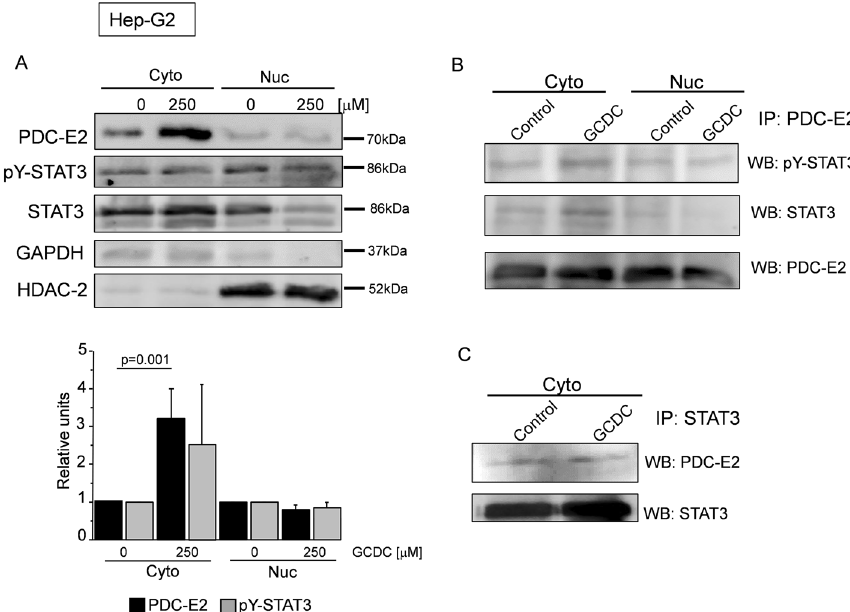
Figure 2. PDC-E2 associates with p-STAT3 and STAT3 in GCDC-stimulated hepatocytes. Hepatocytes (Hep-G2) stimulated with 250 µM of glycochenodeoksycholic acid (GCDC) were collected and subjected to subcellular fractionation in order to obtain cytoplasmic (Cyto) and nuclear (Nuc) fractions. ( A ) PDC-E2, pY-STAT3 and STAT3 were detected by using appropriate antibodies and normalized to GAPDH (cytoplasmic fraction) or HDAC-2 (nuclear fraction). Level of each protein was presented as a mean ± SEM. ( B and C ) Immunoprecipitation reaction (IP) utilized anti-PDC-E2 or anti-STAT3 antibody and contained 500 µg proteins per reaction. PDC-E2 (70 kDa) and pY-STAT3 or STAT3 (both 86 kDa) were detected by Western blot (WB). IP experiments were repeated three times on independent batches of cells.